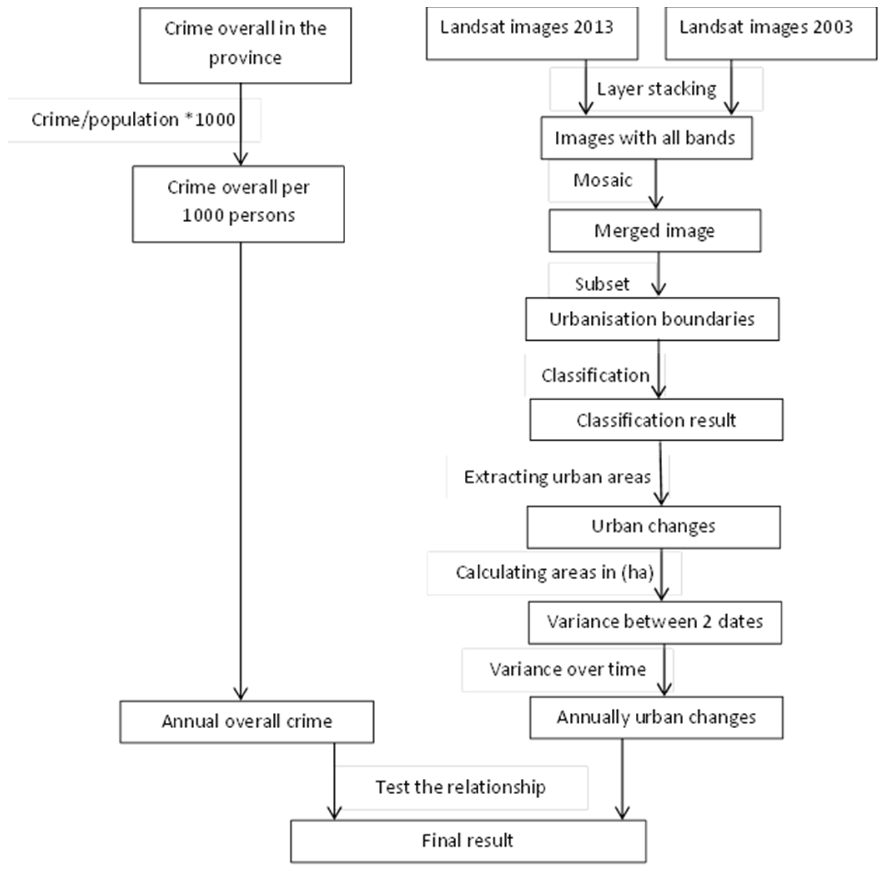
Figure 2. Research Figure 2. Research process.